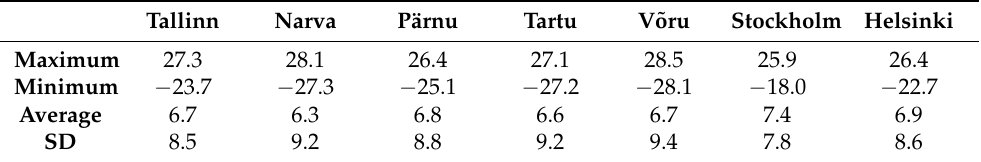
Table 2. Statistical indicators of air temperatures ( ◦ C) in the cities of the central Baltic area from 2005 to